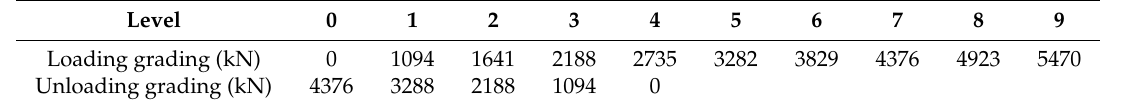
Table 2. Classification table of pile loading and unloading test.